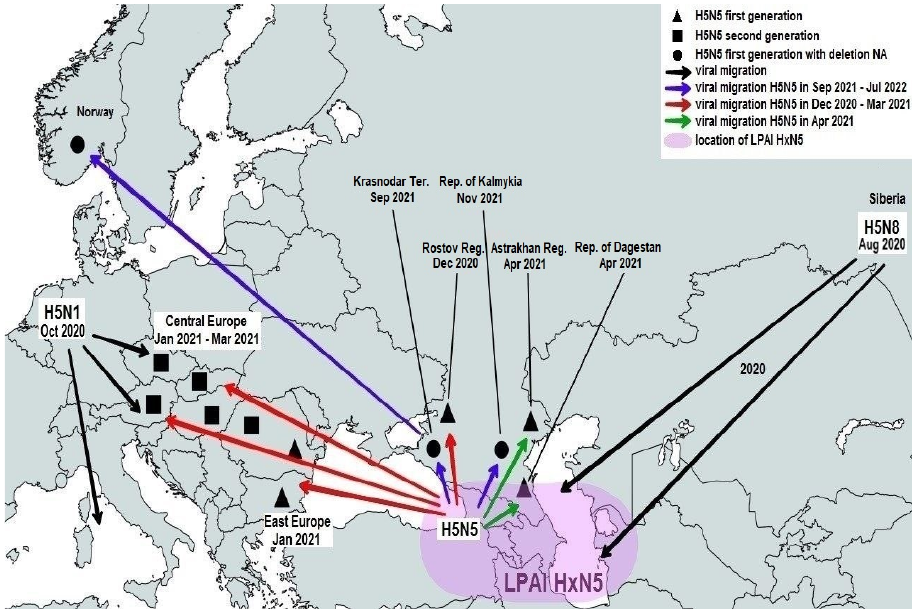
Figure 10. Spread of H5N5 avian influenza virus during 2021–2022.